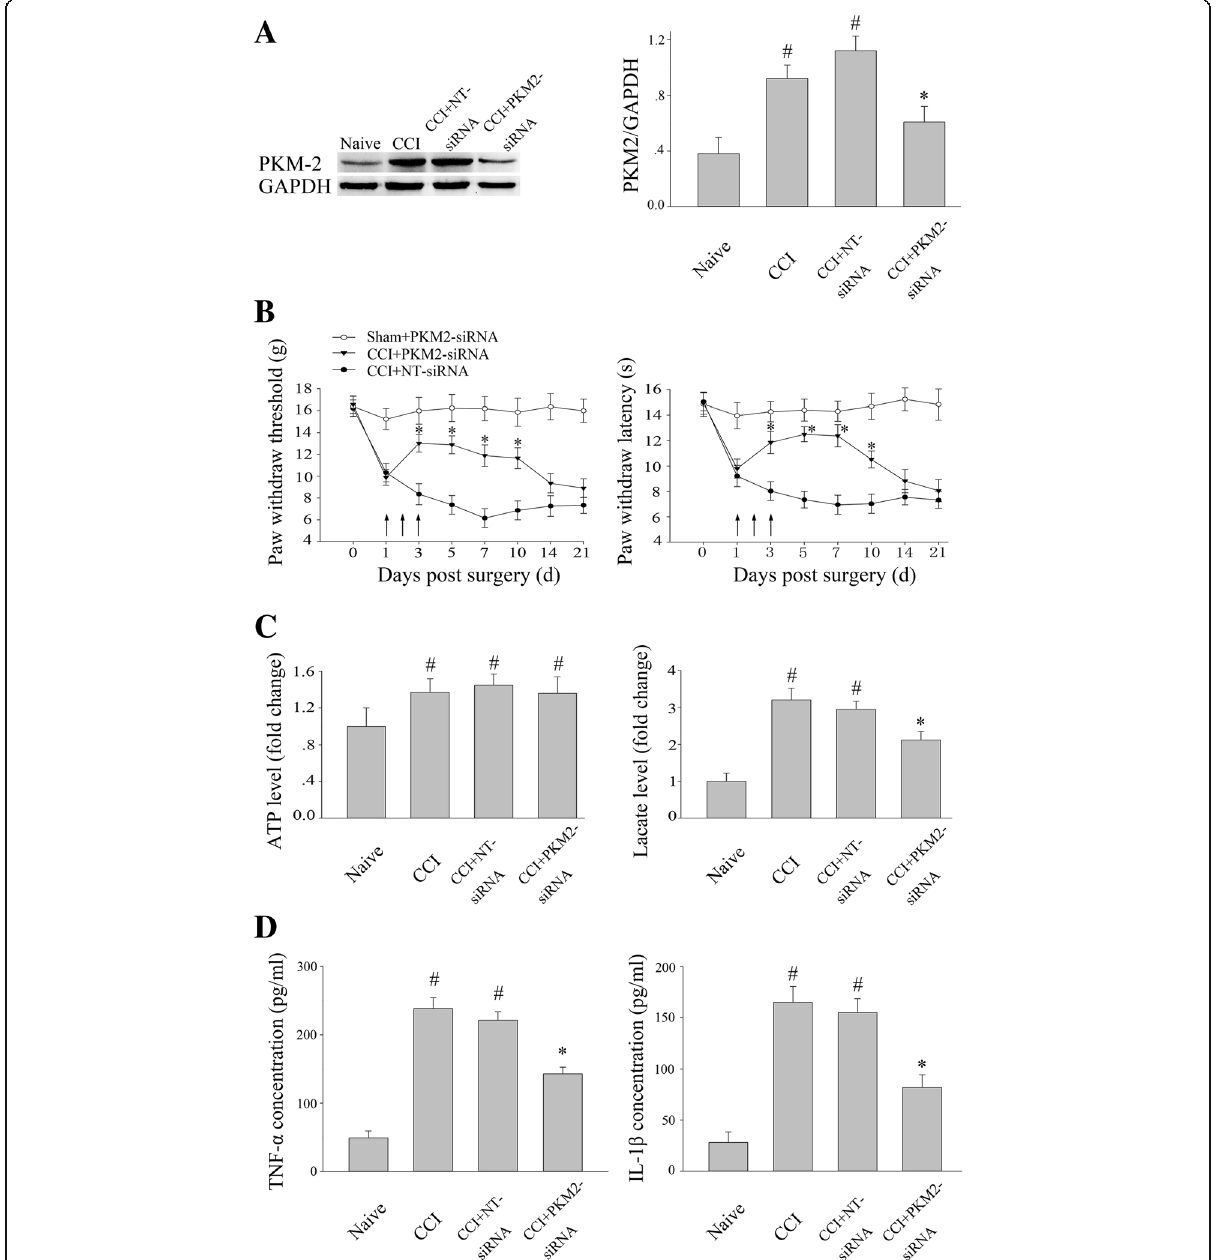
Fig. 3 Intrathecal PKM2 siRNA treatment attenuated pain hypersensitivity and the production of lactate and pro-inflammatory transmitter induced by CCI. a The expression of PKM2 following intrathecal injection of siRNAs after CCI; PKM2 siRNA and NT siRNA (daily for 3 consecutive days, 15 μ l each time, 0.75 μ g/ μ l) were intrathecally injected. Tissues were harvested at day 3, 6 h after the last injection. * P < 0.05 versus NT siRNA group, # P < 0.05 versus naïve group. Four rats per group. b Intrathecal injection of PKM2 siRNA for three consecutive days (day 1, 2, 3) increased paw withdraw threshold and latency for almost 7 days (day 3 to day 10). c PKM2 siRNA significantly attenuated lactate production, while ATP production were not influenced. d Meanwhile, both TNF- α and IL-1 β production were also inhibited by PKM2 siRNA. * P <0.05 versus NT siRNA group. # P <0.05 versus naïve group. Four rats per